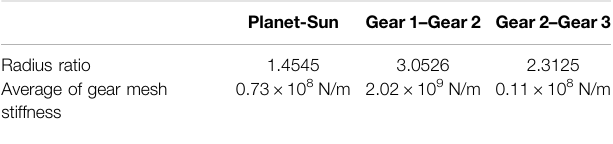
TABLE 3 | Comparison of the gear radius ratio and the average gear mesh